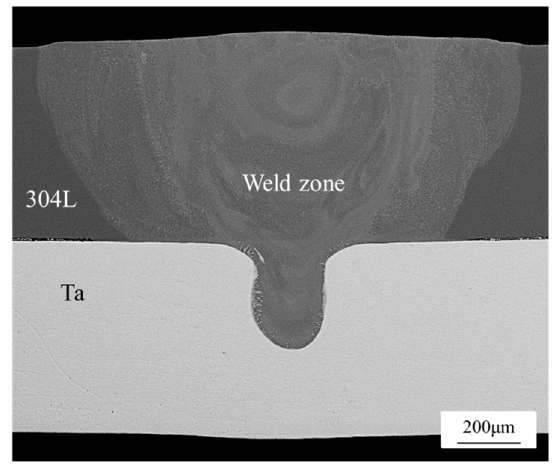
Figure 5. Joint section morphology.